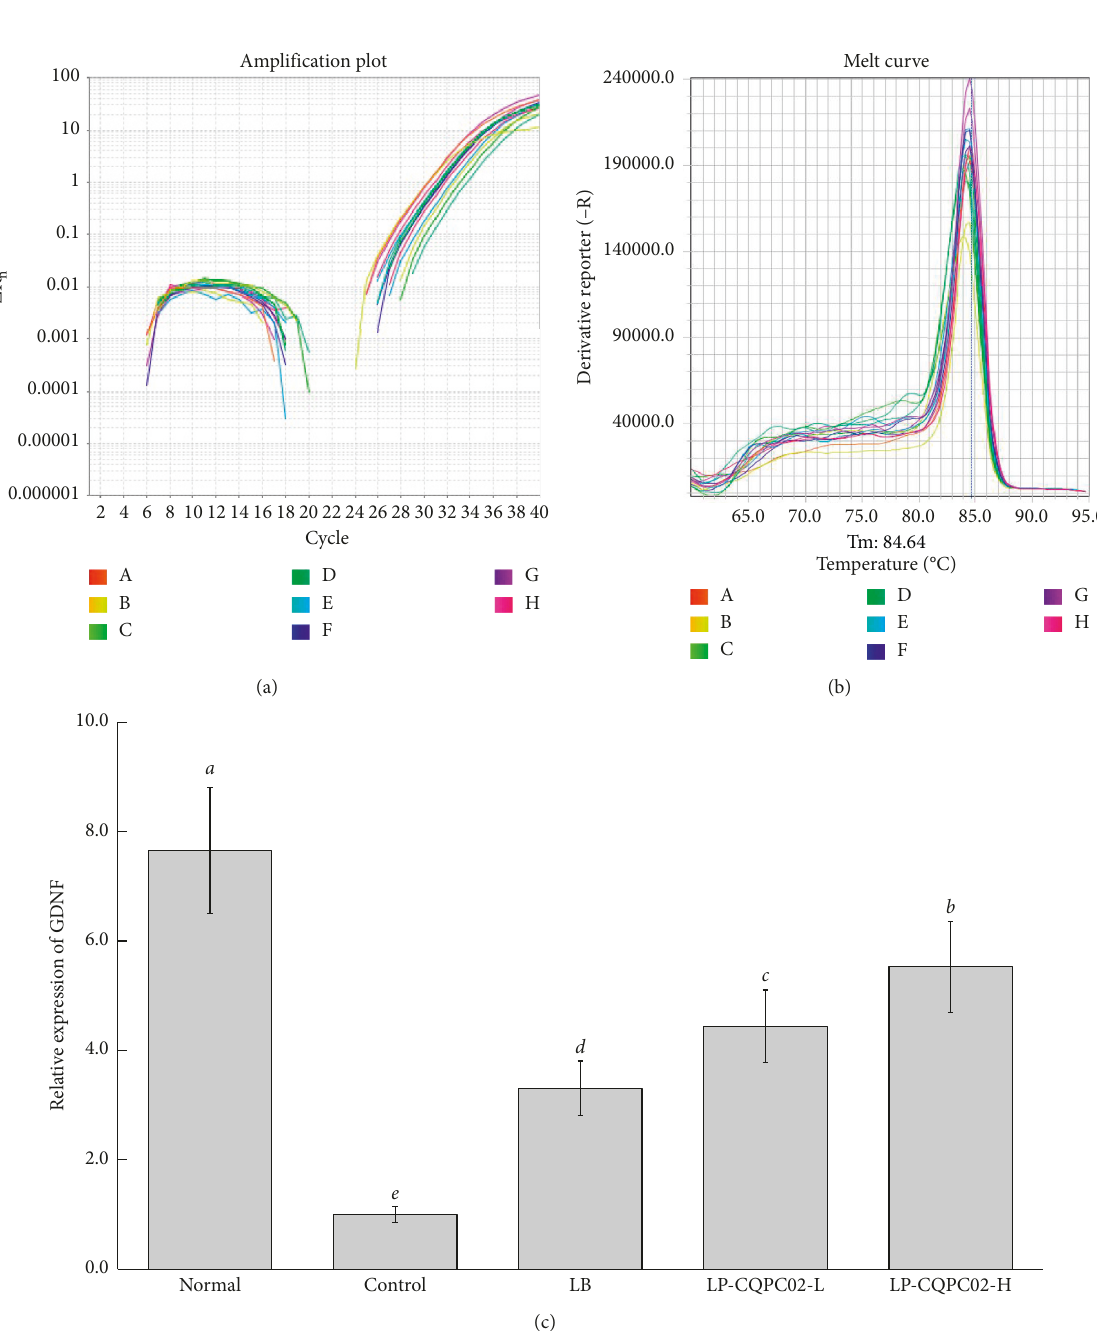
Figure 6: The mRNA expression level of GDNF in the small intestine tissue of mice. (a) Amplification curve, (b) dissolution curve, and (c) relative expression. Values presented are the mean ± standard deviation. a–d The mean values with different letters in the same bars are significantly different ( p < 0.05) according to Duncan’s multiple-range test; there was no significant difference in the same letter repre- sentation between the two bars ( p > 0.05), but there was significant difference in the different letter representation ( p < 0.05). LB: Lactobacillus delbrueckii subsp. bulgaricus (1.0 × 10 9 CFU/kg b.w. gavage); LP-CQPC02-L: Lactobacillus plantarum CQPC02 (1.0 × 10 8 CFU/kg b.w. gavage); and LP-CQPC02-H: Lactobacillus plantarum CQPC02 (1.0 × 10 9 CFU/kg b.w.